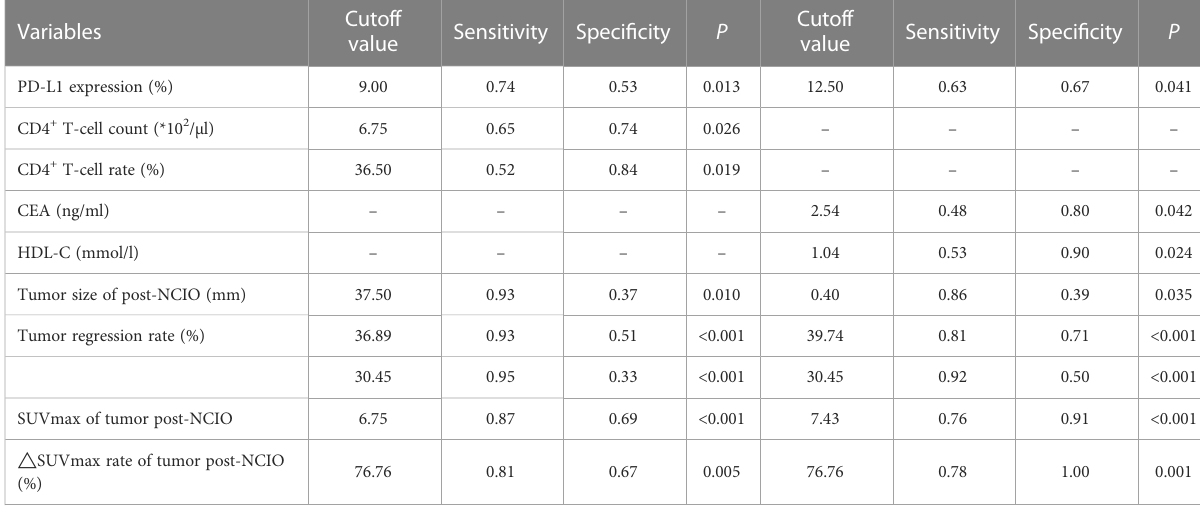
TABLE 4 Receiver operating characteristic curves analyses for pCR or MPR.